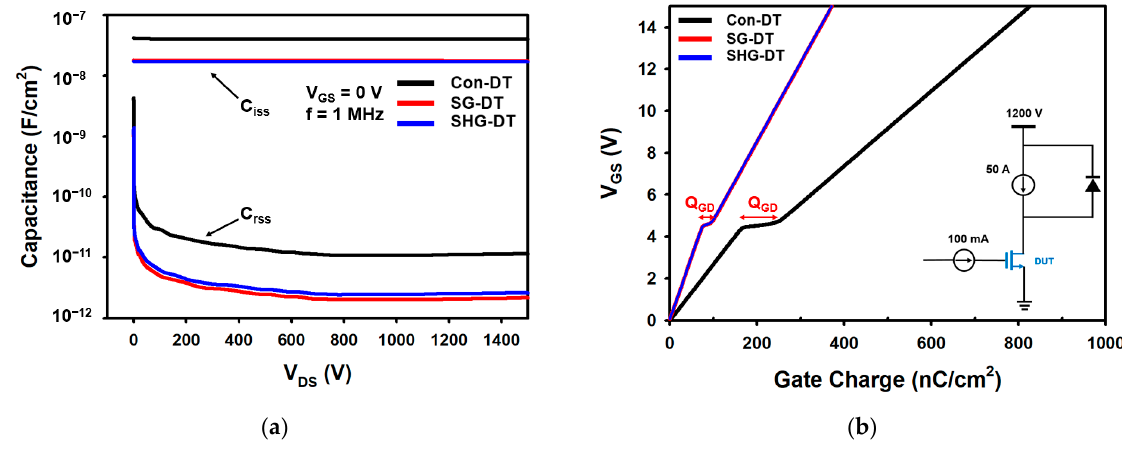
Figure 4. Comparison of Con-DTMOS, SG-DTMOS, and SHG-DTMOS of ( a ) C iss and C rss . ( b ) Gate charge. Table 2. Static and dynamic characteristics of each devices.